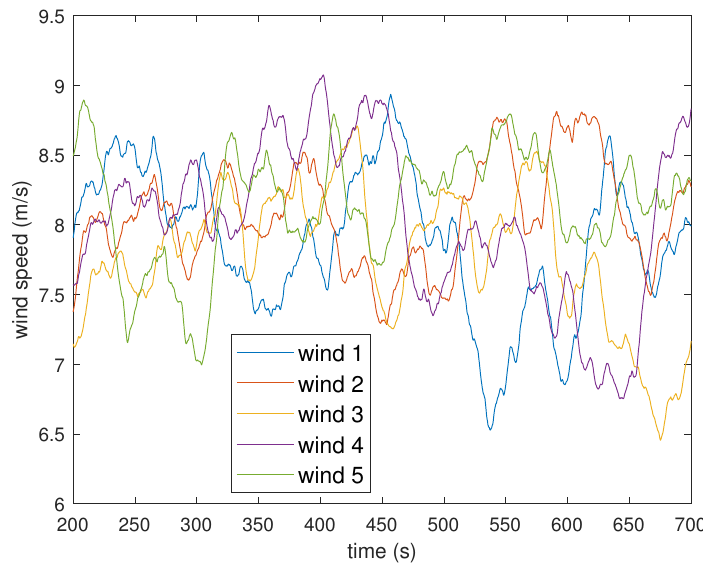
Figure 2. Effective wind speeds for turbines 1 to